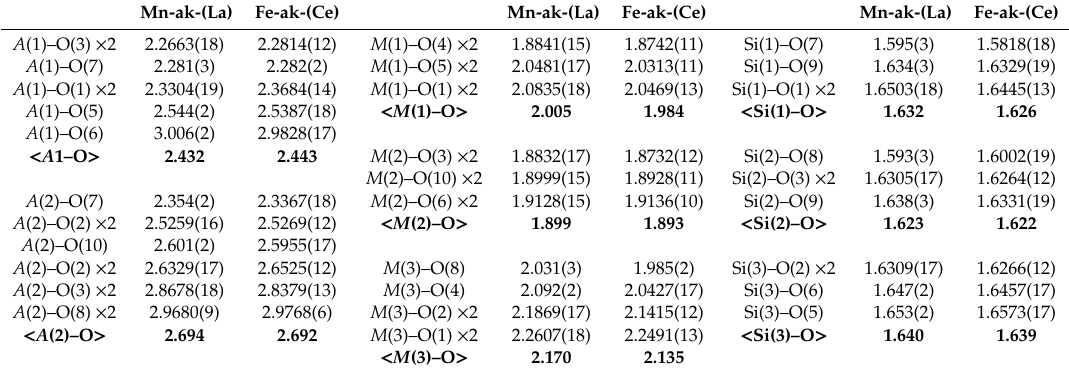
Table 6. Selected bond distances (Å) for manganiakasakaite-(La) [Mn-ak-(La)] and ferriakasakaite-(Ce) [Fe-ak-(Ce)].